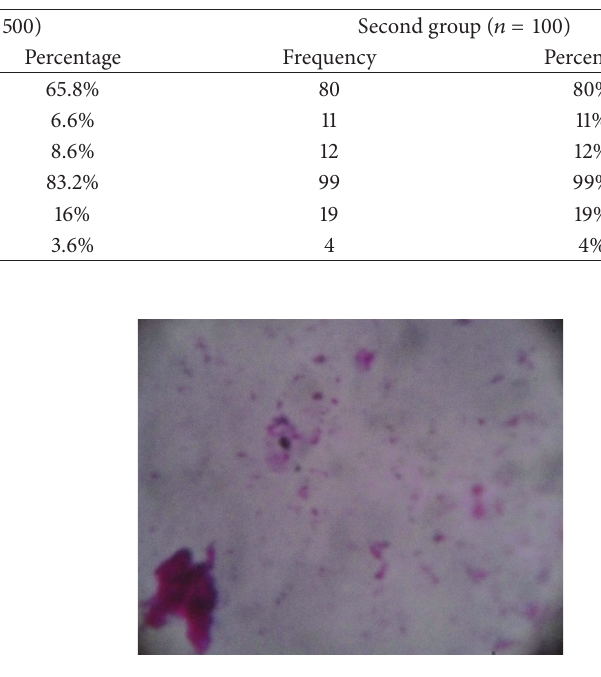
Figure 3: Ring of Plasmodium falciparum in thick blood film ( ×